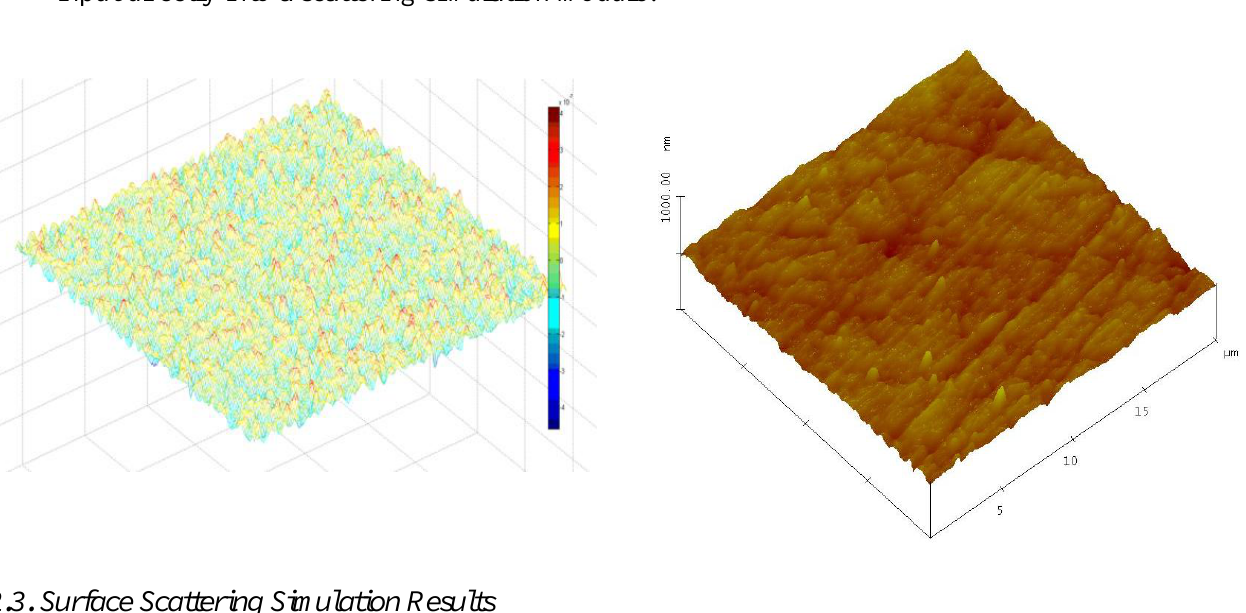
Figure 1. ( Left ) A computer-generated surface with nanoscale surface roughness constructed with a Gaussian distribution of peaks and valleys. ( Right ) A 20 × 20 micrometer height profile scan of a diamond-polished epoxy surface, obtained using an AFM, which can be input directly into a scattering simulation